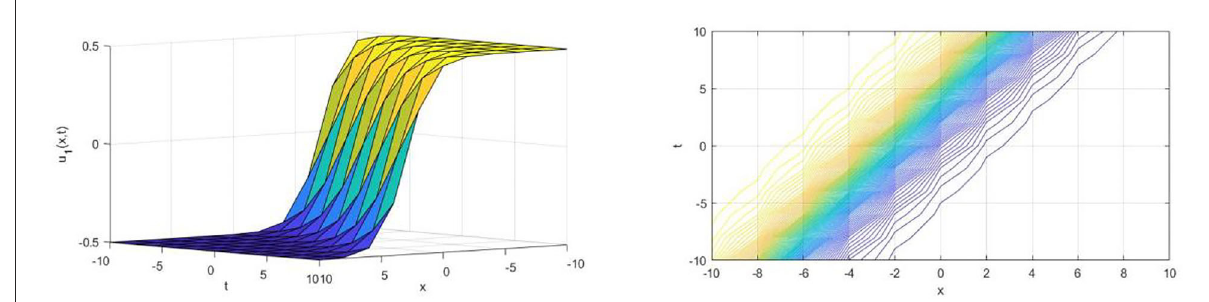
FIGURE1 The kink wave solution of u 1 ( x , t ) in 3D and contour.